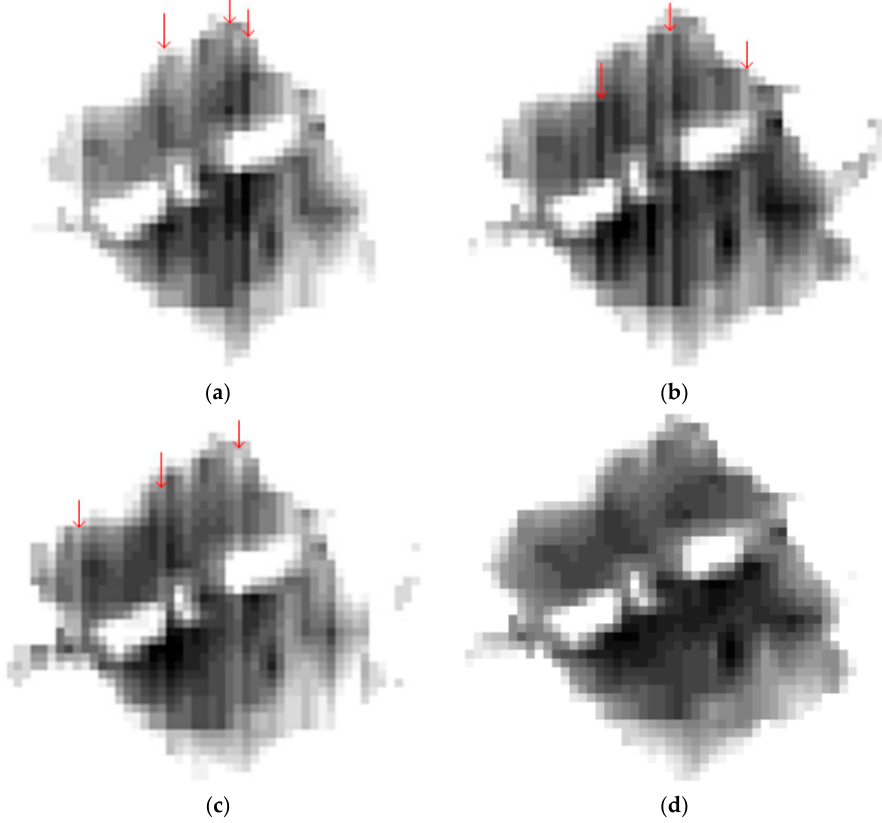
Figure 18. The detail of results (the images were stretched for display). ( a ) Detailed image of the red